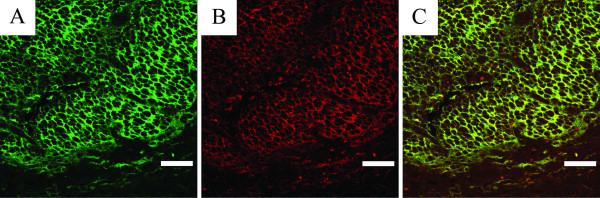
The staining pattern of a primary neuroblastoma. A, expression of polySia-NCAM detected with the EndoNA2-GFP fusion protein. B, NCAM expression (stained with Alexa Fluor 594) of the same location. C, overlay image of A and B identifying colocalized expression of polySia-NCAM and NCAM. Scale bar, 40 μm.